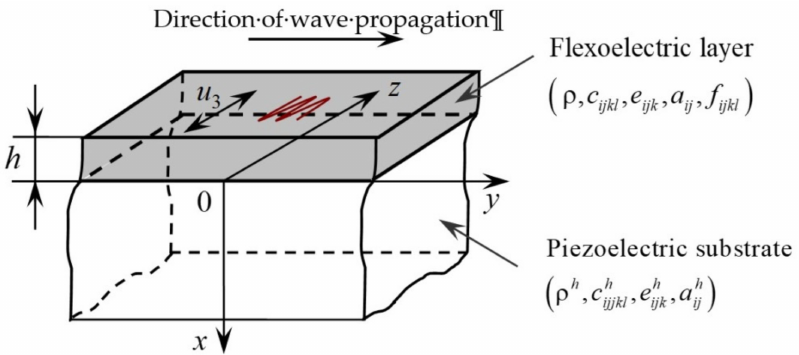
Figure 1. Layered piezoelectric structure and choice of the coordinate